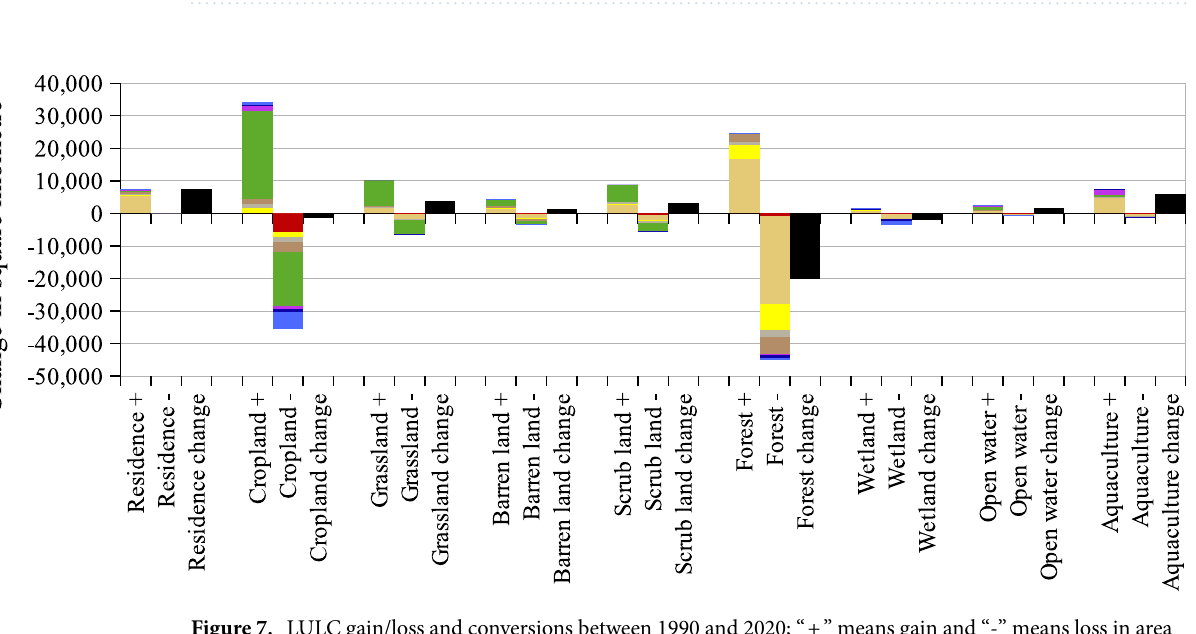
Figure 6. Temporal dynamics of net changes in LULC across Vietnam, extracted from the level-1 Vietnam- wide annual LULC data sets in the years 1990, 1995, 2000, 2010, 2015, and 2020. The data labels represent the percentage of changes (%) within five-year intervals. The positive and negative values indicate an increase and a decrease, respectively.